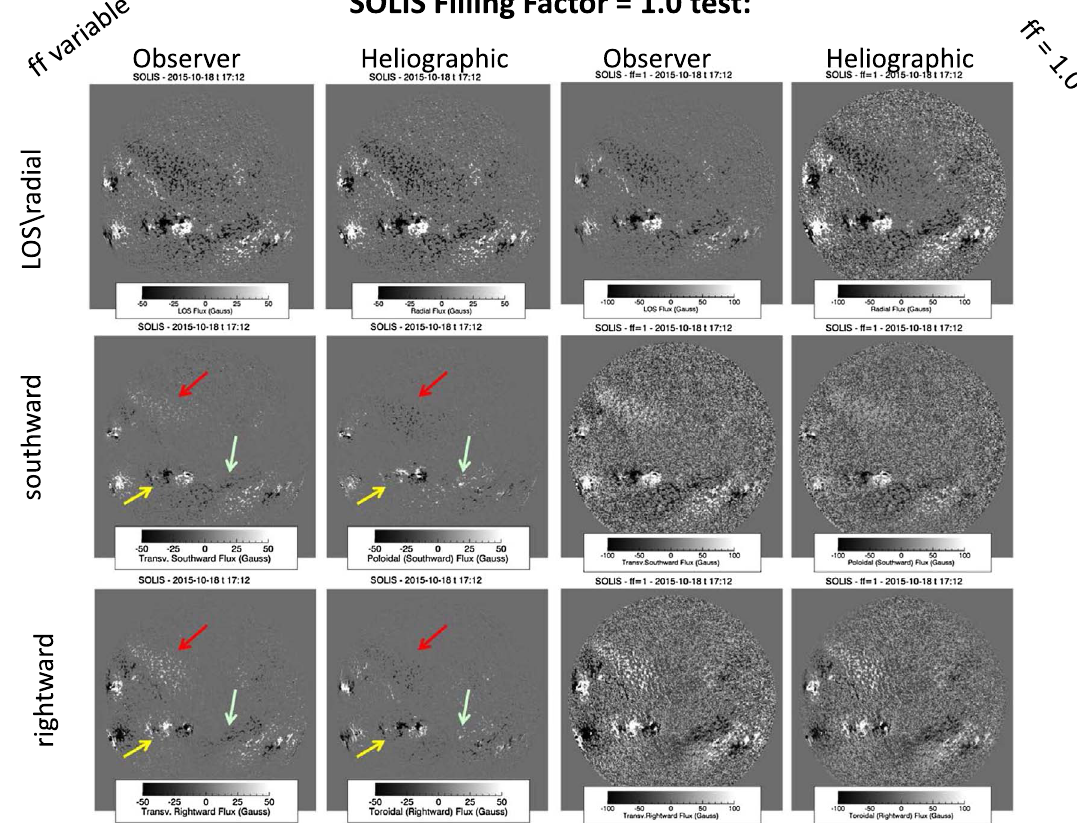
Fig. A.1. Full disk images of B r (upper row), B h (middle) and B u (low row). First and third columns show the vector fi eld components in image coordinate system, while second and fourth columns are in the heliographic coordinate system. Three examples are marked by arrows of different color. Setting a to unity emphasizes pixels, which otherwise are below the noise